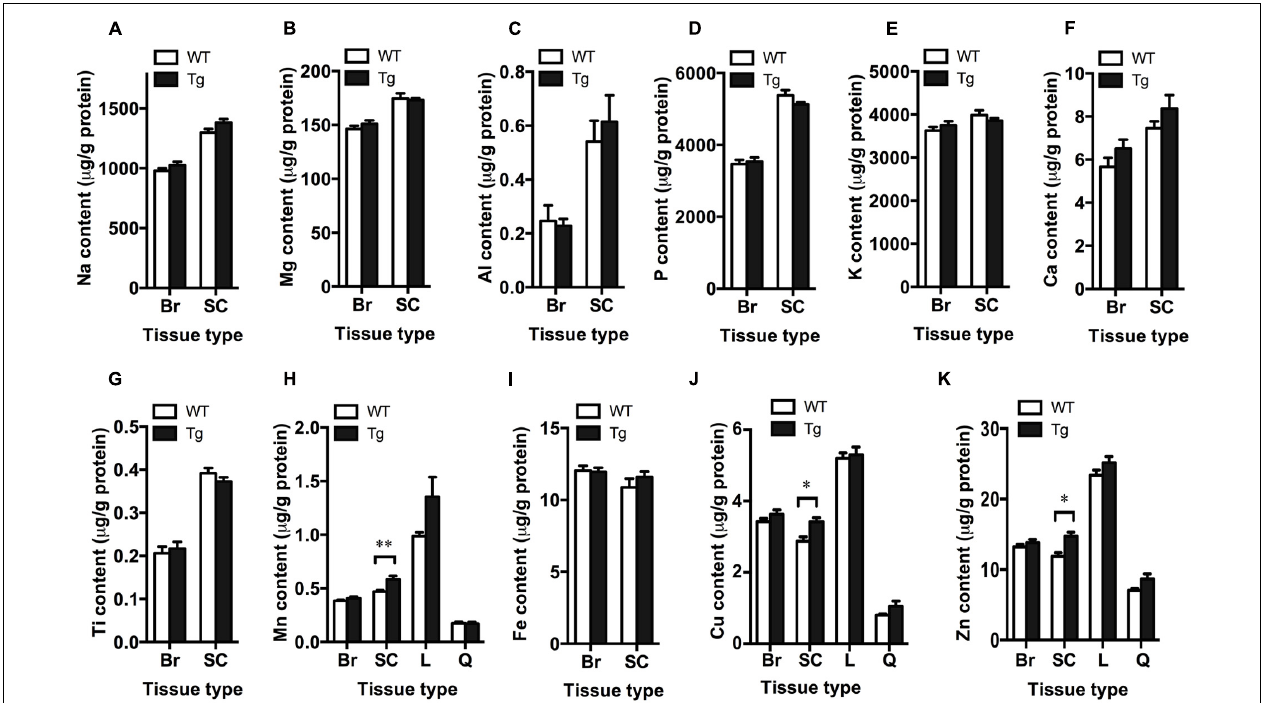
FIGURE 2 | Increased metal content in the spinal cord ofTDP-43 A315T mice. ICP-MS analysis of bulk metal content in the brain (Br), spinal cord (SC), liver (L) and quadriceps muscle (Q) ofTDP-43 A315T mice (Tg), and wild-type litter mates (WT). (A–K) Planned comparisons revealed no significant